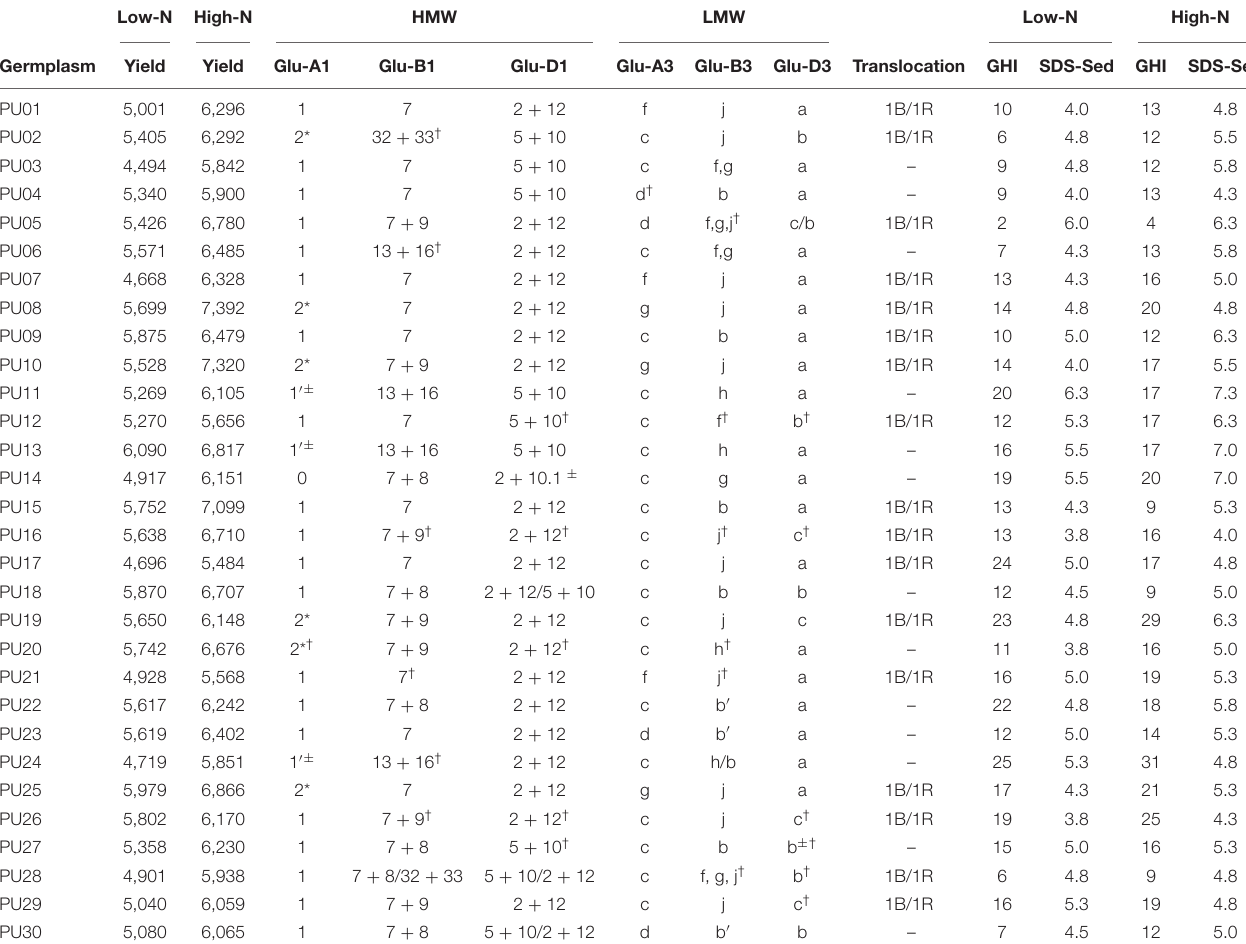
TABLE 3 | Allelic variation of high (HMW) and low molecular weights (LMW) for glutenin subunits and presence of 1B/1R translocation for each line. Low-N